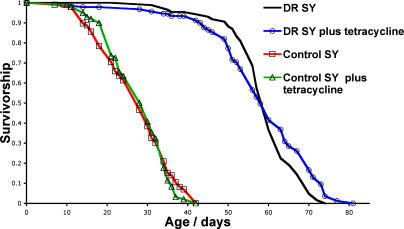
Effect of Tetracycline on Life Span of Female D. melanogaster
The addition of the antibiotic tetracycline to the food media did not have a significant effect on life span at either control or DR concentration food media.